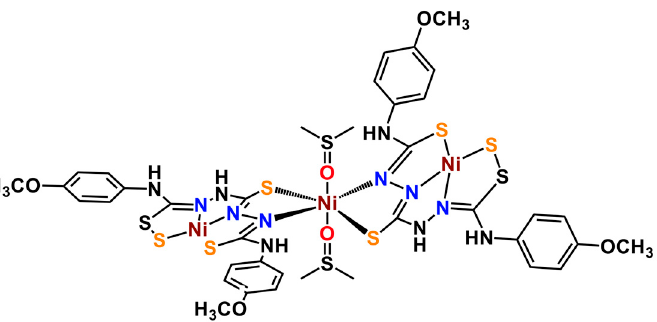
Figure 1. Structure of the trinuclear nickel thiocarbohydrazone complex, [N i3 (SH 3 L) 2 (DMSO) 2 ] , ( Ni 3 L 2 ) presented in this work. ( Ni 3 L 2 ) presented in this